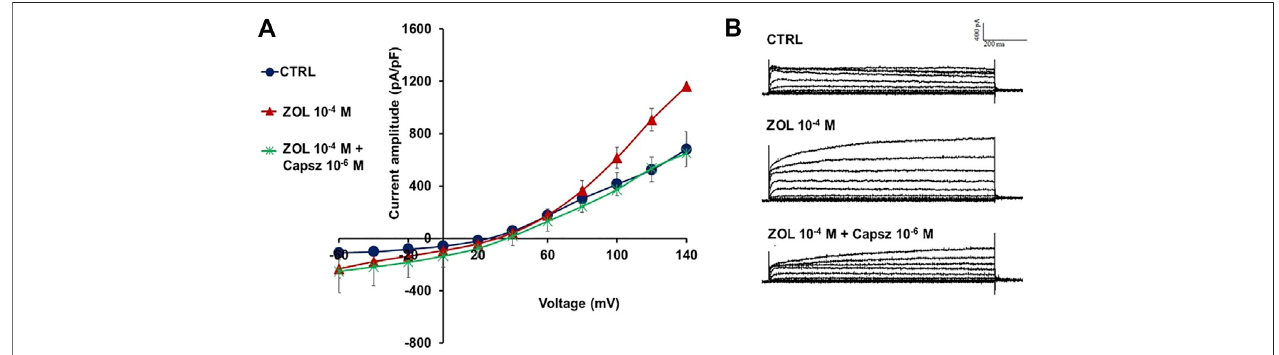
FIGURE 5 | Zoledronic acid (ZOL) effects on TRPV1 channel on neuronal SH-SY5Y cells. (A) Macroscopic currents induced by ZOL (10 − 4 M) using a whole-cell con fi guration on SH-SY5Y neuronal cells. Capsazepine (Capsz) completely closed ZOL-evoked currents. Current was obtained in response to voltage pulses from - 60 mV to +140 mV in 20 mV steps, starting from HP = -60 mV (Vm). Cells characterized by the same size were selected for patch-clamp experiments. Each point represented the mean ± SEM (N patches = 5 – 7). Temperature: 21 ± 1 ° C. (B) Sample traces of control (CTRL) current, ZOL-evoked and ZOL + Capsz-evoked instantaneous current.